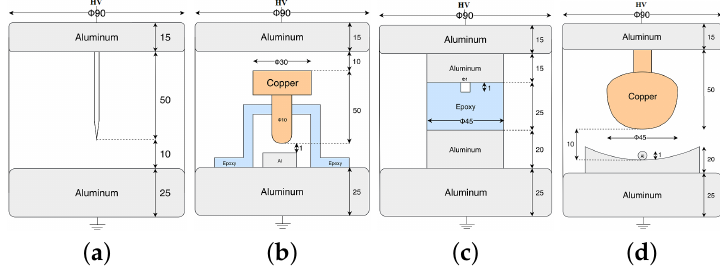
Figure 2. Artificial cells for the simulated ( a ) corona, ( b ) floating, ( c ) void, and ( d ) particle PDs.